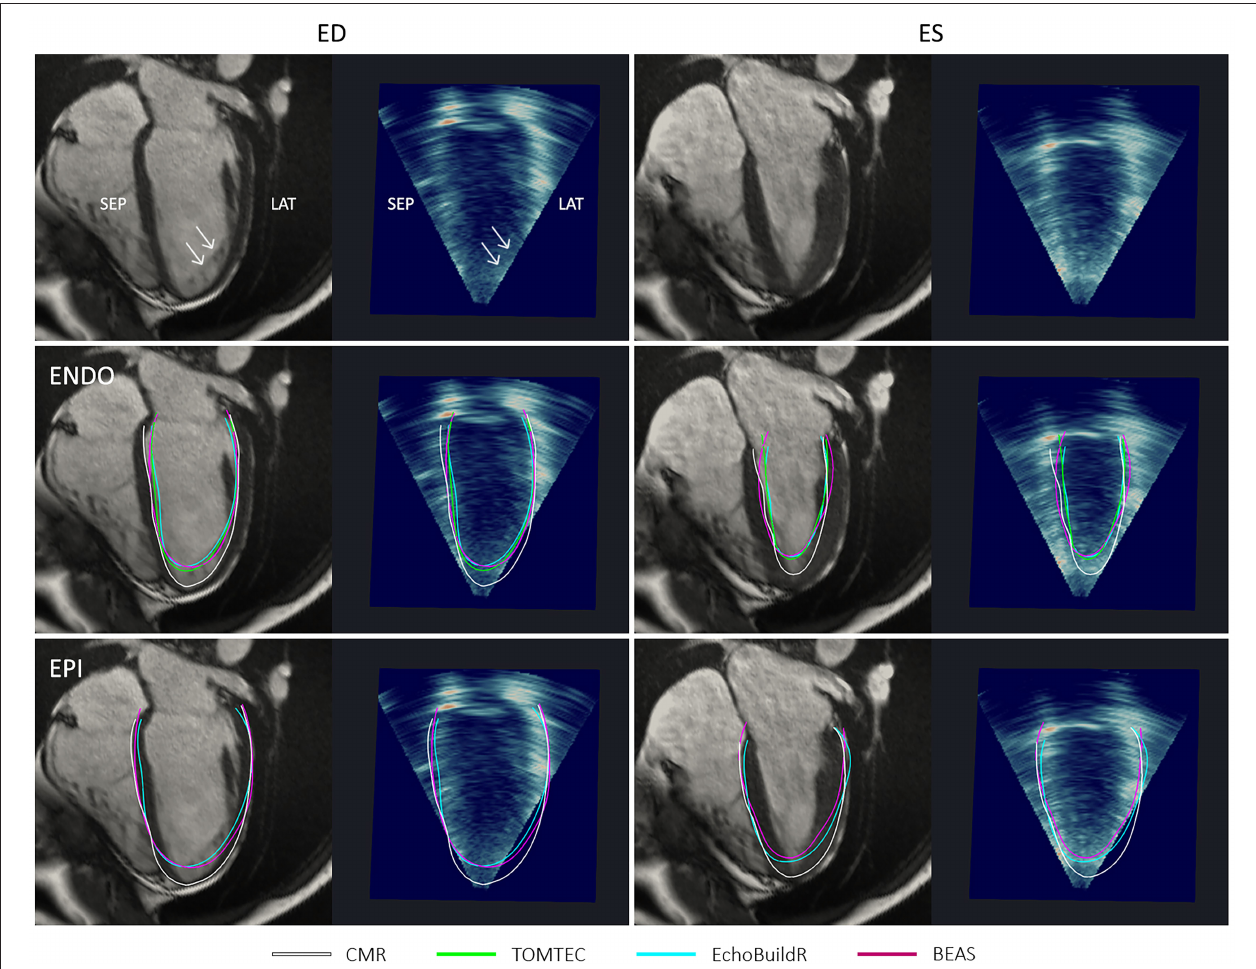
FIGURE 7 | Four-chamber long-axis views by CMR and resliced 3D-echo from a healthy participant, at end-diastole (ED) and end-systole (ES). Top row indicates (with arrows) positions and appearances of apical trabeculations in each modality. Middle row shows endocardial (ENDO) contours, and bottom row shows epicardial (EPI) contours derived using each method indicated in the legend. ANT, anterior; LAT, lateral; SEP, septal; INF,